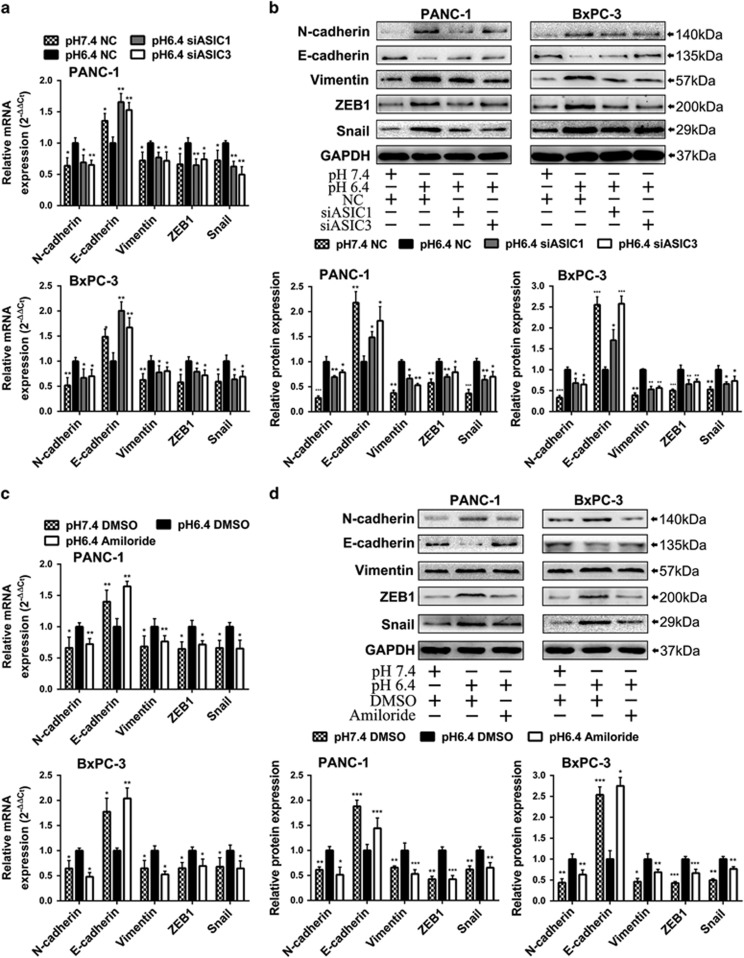
Knockdown of ASIC1 and ASIC3 suppresses acidity-induced EMT of pancreatic cancer cells. (a and b) PANC-1 and BxPC-3 were transfected with negative control (NC) or siRNA of ASIC1 and ASIC3 (siASIC1 and siASIC3) and cultured in pH 7.4 or pH 6.4 medium as indicated for 48 h. The mRNA and protein expression of N-cadherin, E-cadherin, Vimentin, ZEB1, Snail were measured by qRT-PCR and western blot. (c and d) PANC-1 and BxPC-3 were treated with amiloride and DMSO, and cultured in pH 7.4 or pH 6.4 medium as indicated for 48 h. The mRNA and protein expression of N-cadherin, E-cadherin, Vimentin, ZEB1, Snail were measured by qRT-PCR and western blot. Values were normalized against negative control in pH 6.4 medium. Experiments were performed three times in triplicate and are presented as means±S.D. (*P<0.05; **P<0.01; ***P<0.001)